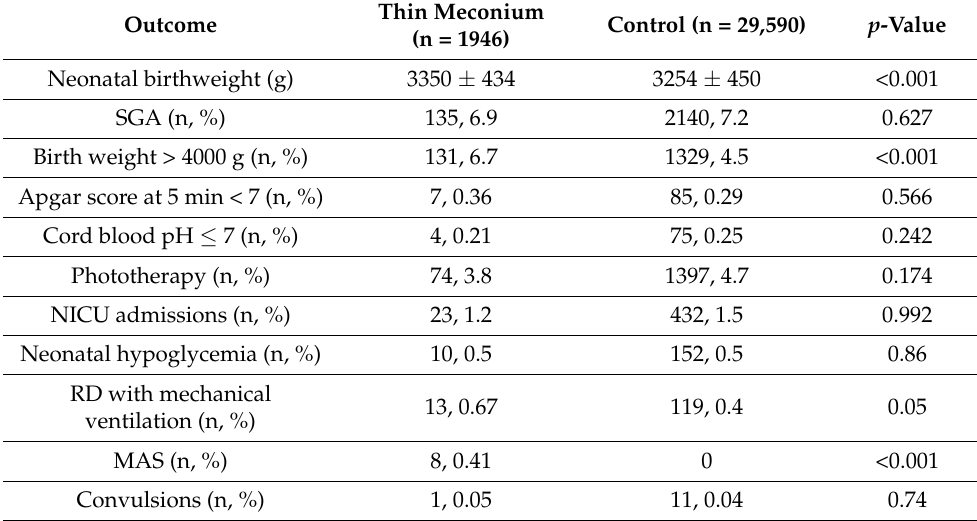
Table 3. Neonatal outcomes of the study groups.